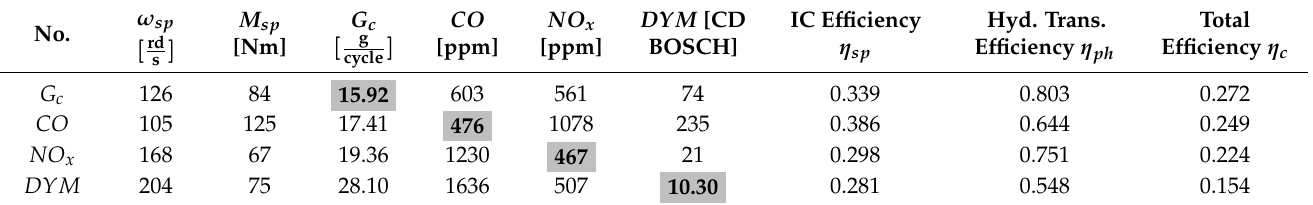
Table 8. Optimal combustion engine duty points for load I and accumulator capacity V a = 0.03 [m 3 ].